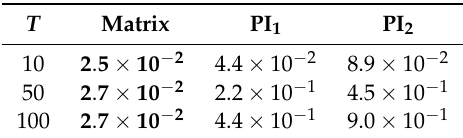
Table 3. Comparison of execution time for the matrix approach and the product integration (PI) methods for computing the approximate solution at T